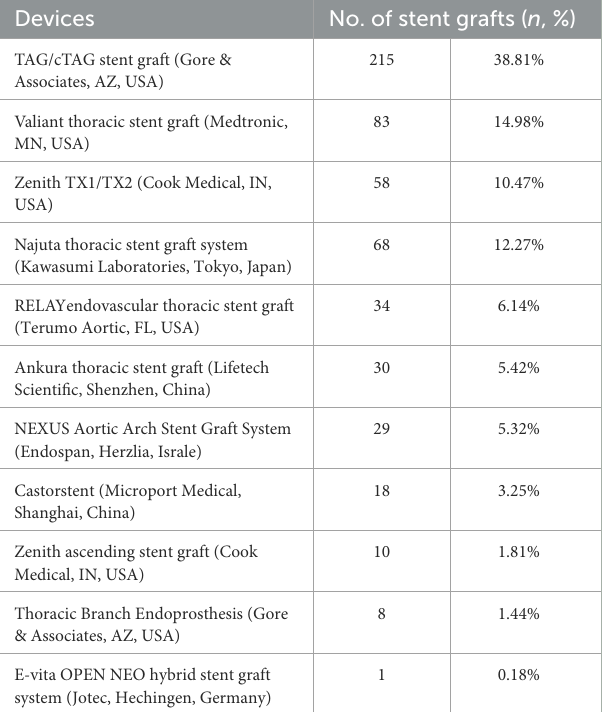
TABLE 4 Stent graft category ( N = 554).